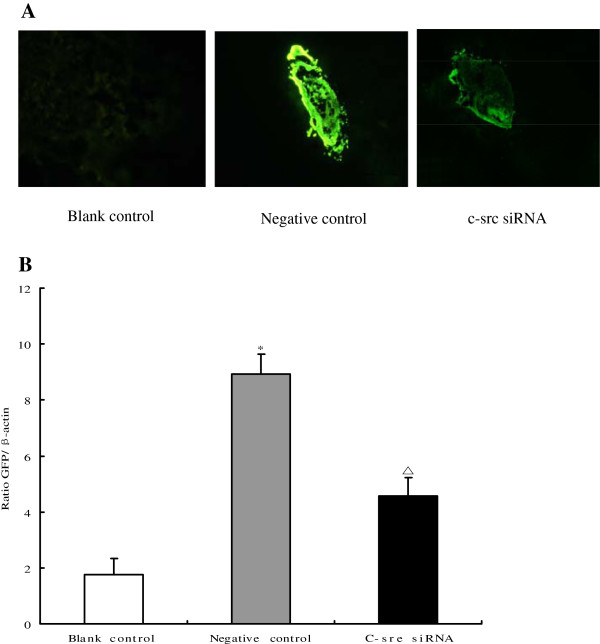
The delivery efficiency of the lentivirus after transfection.A,The GFP fluorescence of frozen ovarian sections 8 days after lentivirus transfection. B, Semiquantitative assay of the relative level of GFP DNA 8 days after lentivirus transfection from six different replicates. Blank control corresponds to the group with c-src-non-targeting oligonucleotides, negative control corresponds to the group with blank vector (lentivirus without siRNA), and c-src siRNA corresponds to the group with lentivirus packaging c-src siRNA. The data are presented as the means ± SEM (n = 3). ** P<0.01 compared with blank control; Δ P<0.05 vs. negative control.